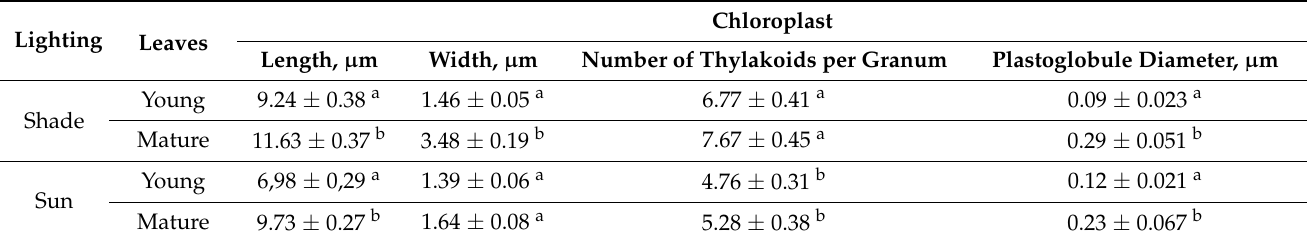
Table 1. Morphometric parameters of chloroplasts in palisade parenchyma cells of young and matured leaves of Hydrochari morsus-ranae in different lighting.